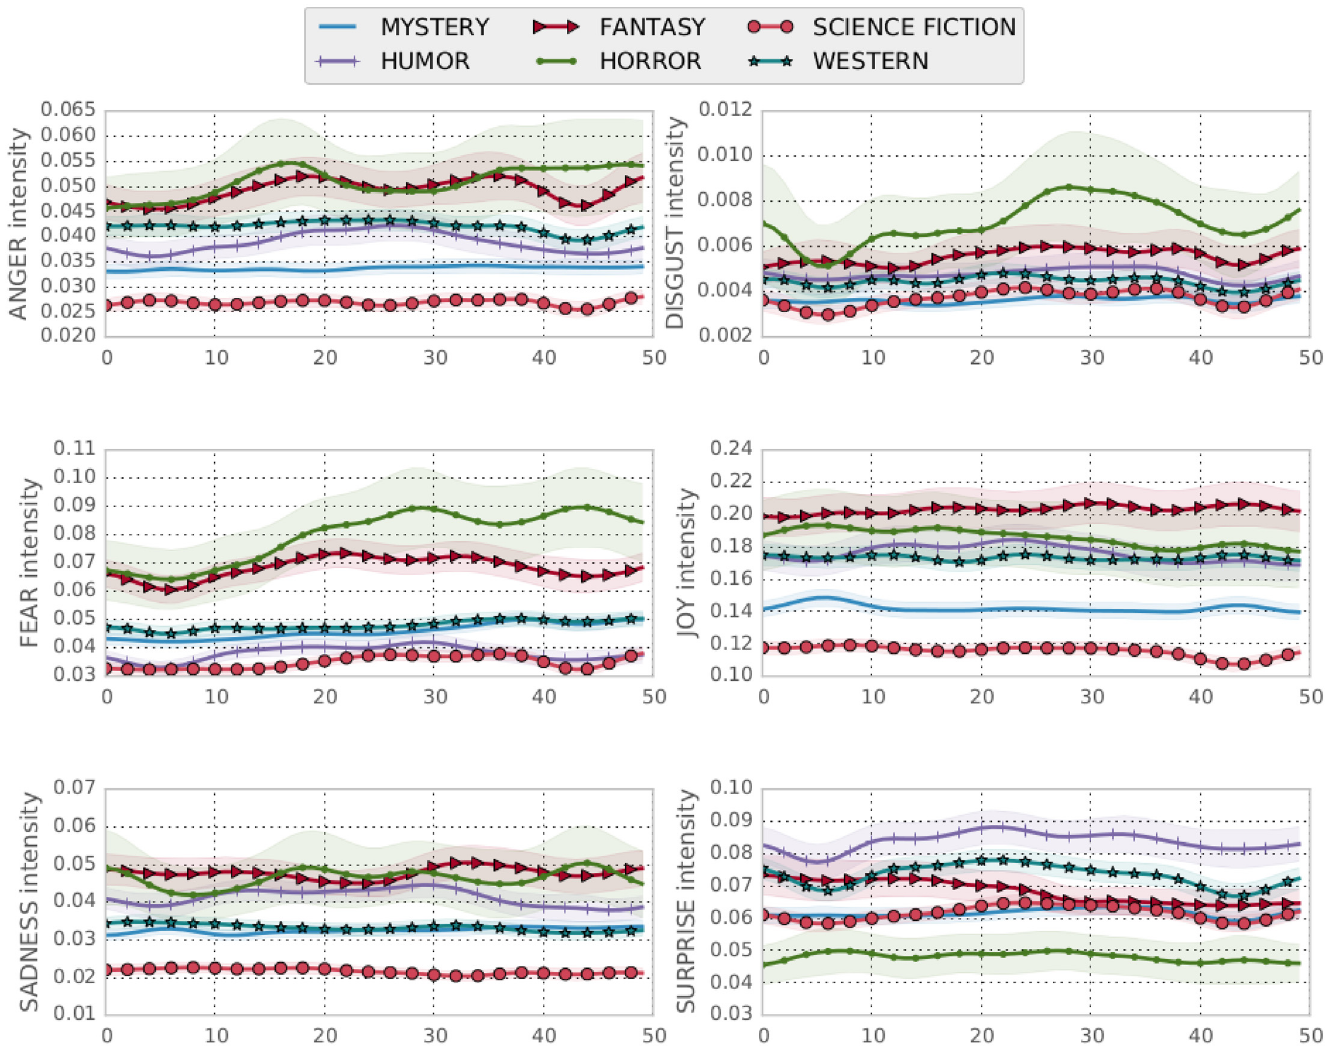
Fig 5. Average strength of each emotion among all texts. Statistical significance for a = 0.05.